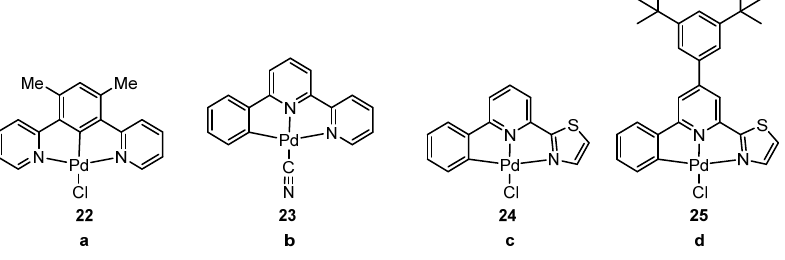
Figure 9. Chemical structures of Pd(II) complexes 22 – 25 containing symmetrical ( a ) and non- symmetrical ( b , c , d ) tridentate ligands, which are not luminescent in solution at room temperature, but show a strong fluorescence in solvent matrix at 77 K. Adapted from references